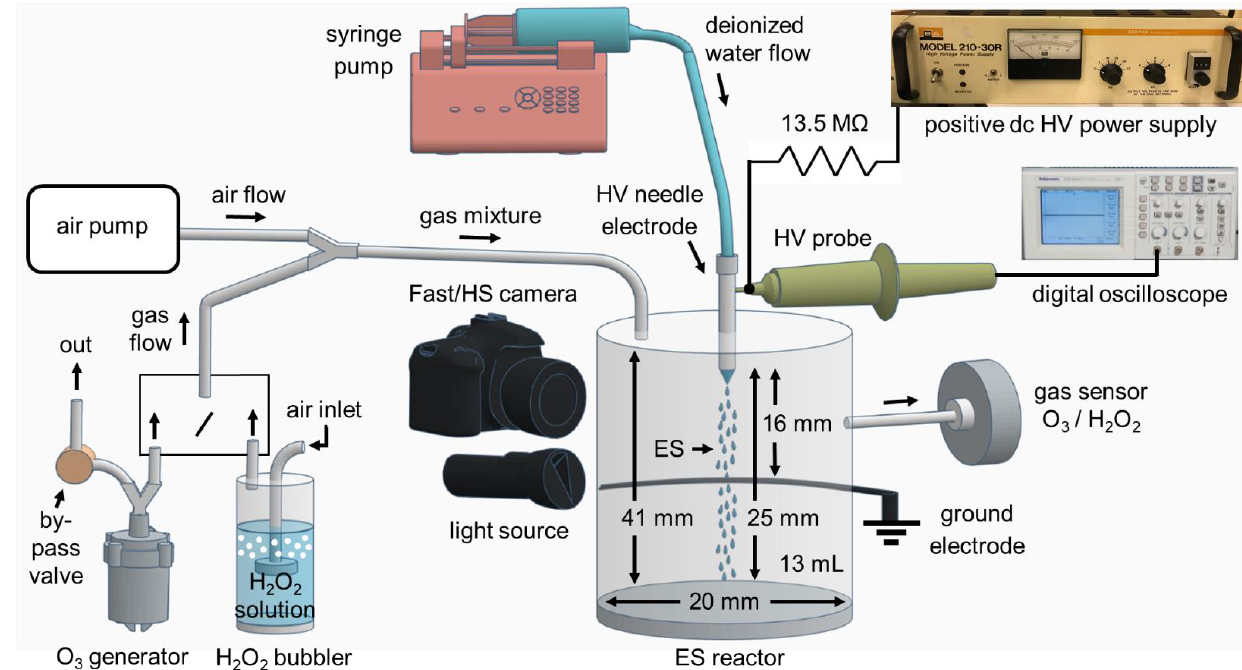
Figure 2. Schematic of the experimental setup for the Fast/high speed (HS) camera imaging technique and investigation H 2 O 2 and O 3 transport into water electrospray (ES).